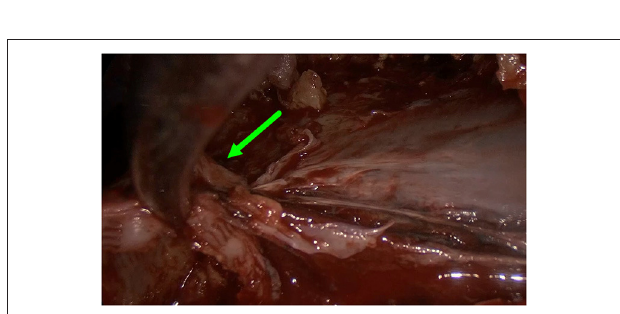
FIGURE 3 | Intraoperative image showing removal of visceral pleura.